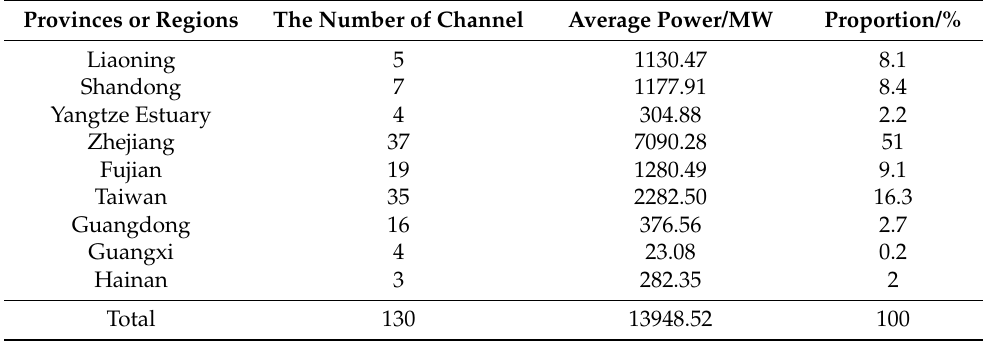
Table 1. Tidal current energy resource reserves of several provinces in 1986 national assessment [12,13].